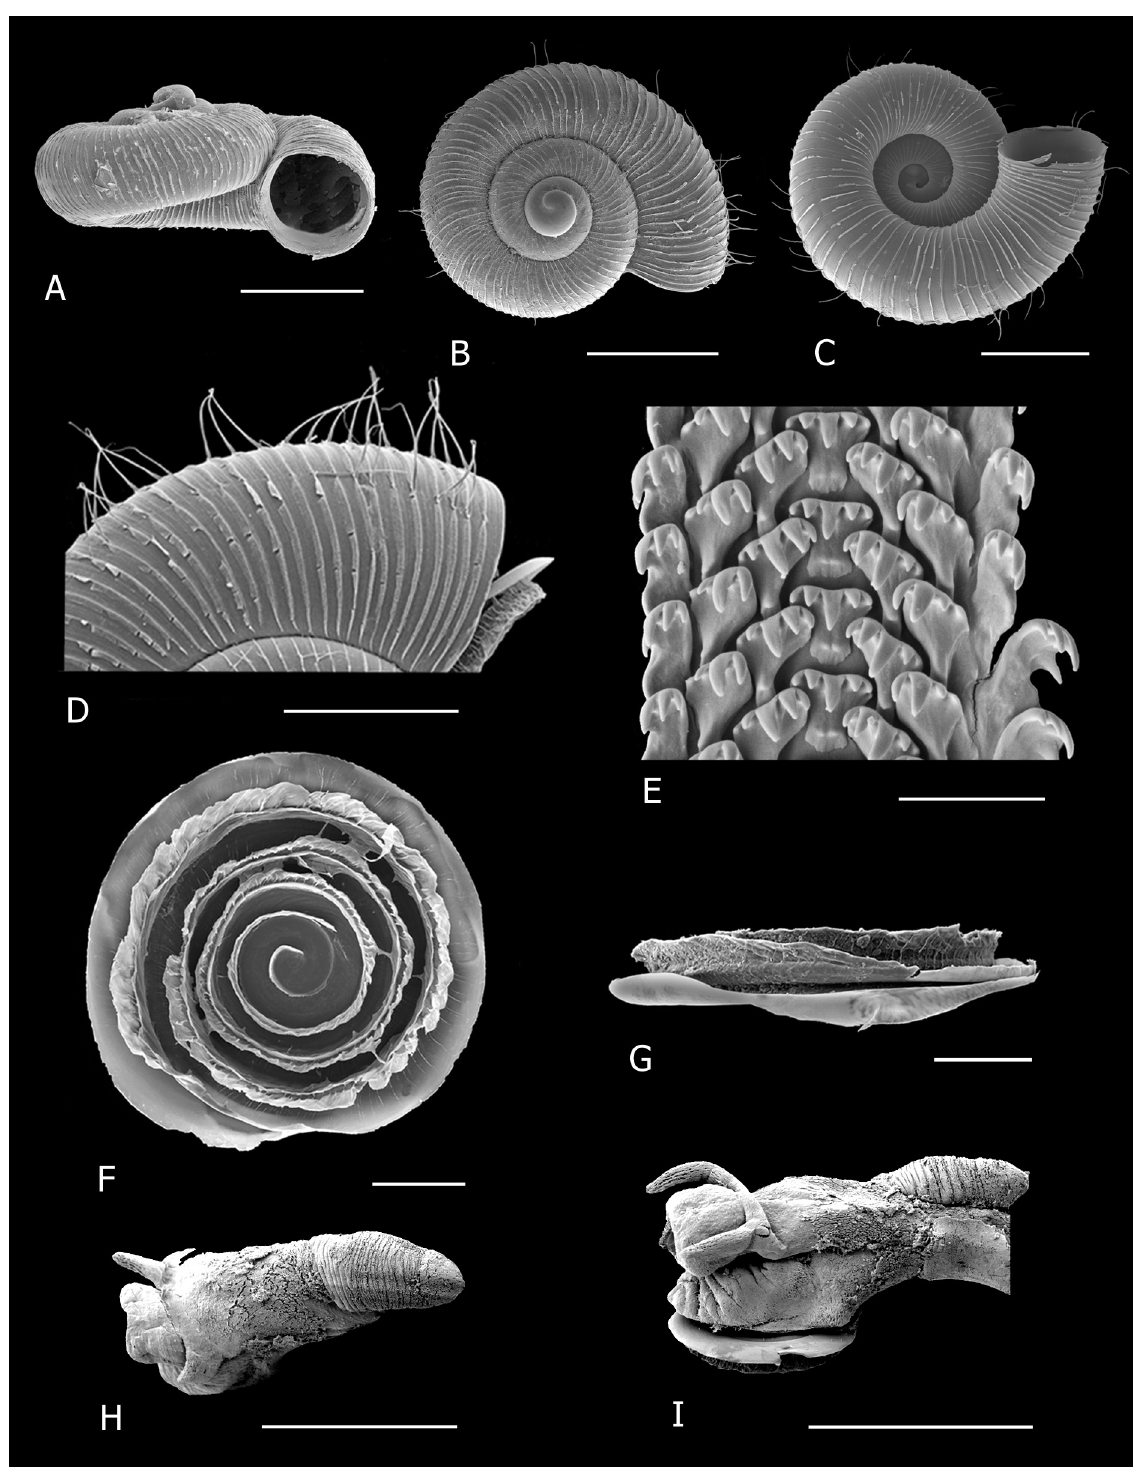
Fig. 30. Afrocyclus oxygala gen. et sp. nov. A . Aperture view (ELM D16896). B . Dorsal view (ELM W3647). C . Ventral view (ELM W3647). D . Portion of juvenile shell, showing detail of periostracum (ELM W3647). E . Portion of radula (ELM W3646). F–G . Operculum (ELM W3647). H–I . Penis, showing position, dorsal and lateral views (ELM W3647). Scale bars: A–D, H = 1 mm; E = 20 µm; F–G = 200 µm; I = 500